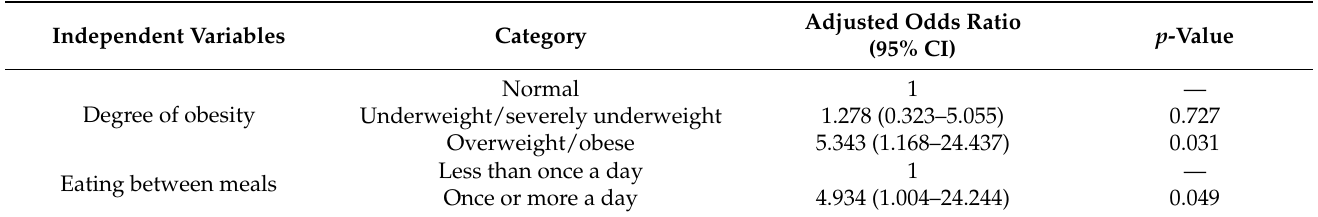
Table 6. Predictors of developmental failure of swallowing threshold based on binary logistic regression